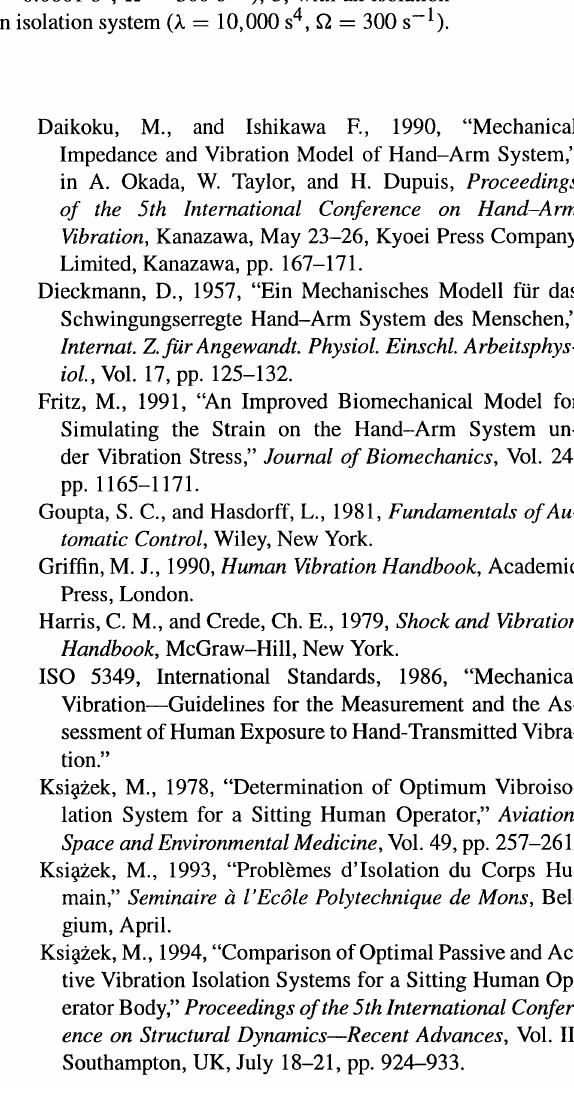
FIGURE 8 The magnitudes of cfJ(s) for the 3-DOF hand model and the narrow-band noise ac celeration excitation: 0, without an isolation system; 1, with an isolation system (A = 0.0001 s4, Q = 100 s-I); 2, with an isolation system (A = 0.0001 s4, Q = 300 s-I); 3, with an isolation system (A = 10,000 s4, Q = 100 s-I); 4, with an isolation system (A = 10,000 s4, Q = 300